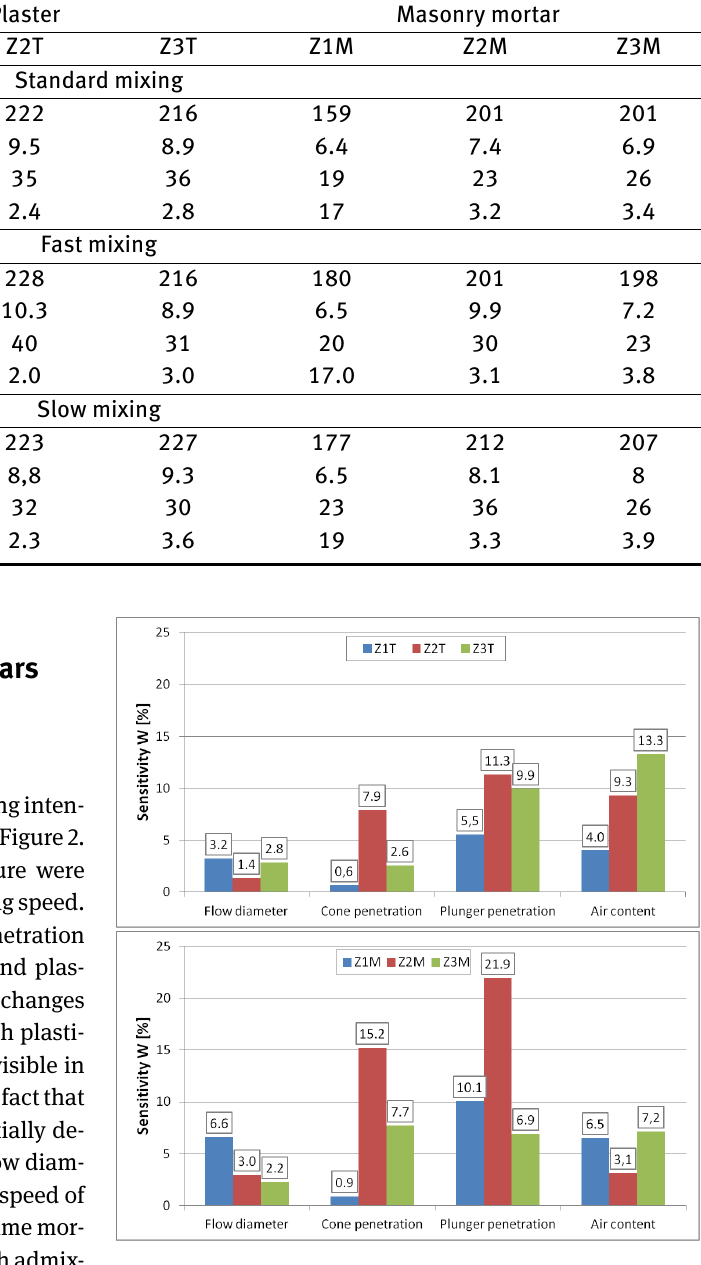
Figure 2: The sensitivity of the properties of plasters (top) and mor- tars (bottom) to different mixing